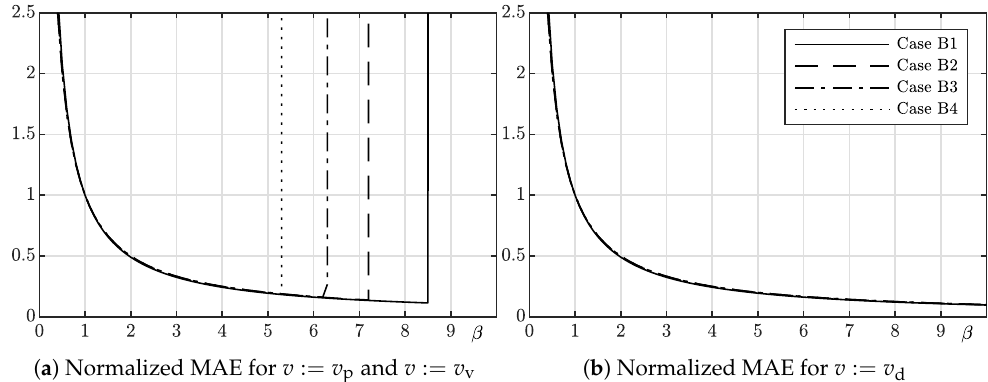
Figure 4. Values of normalized MAE criterion in the simulation of scenario B.